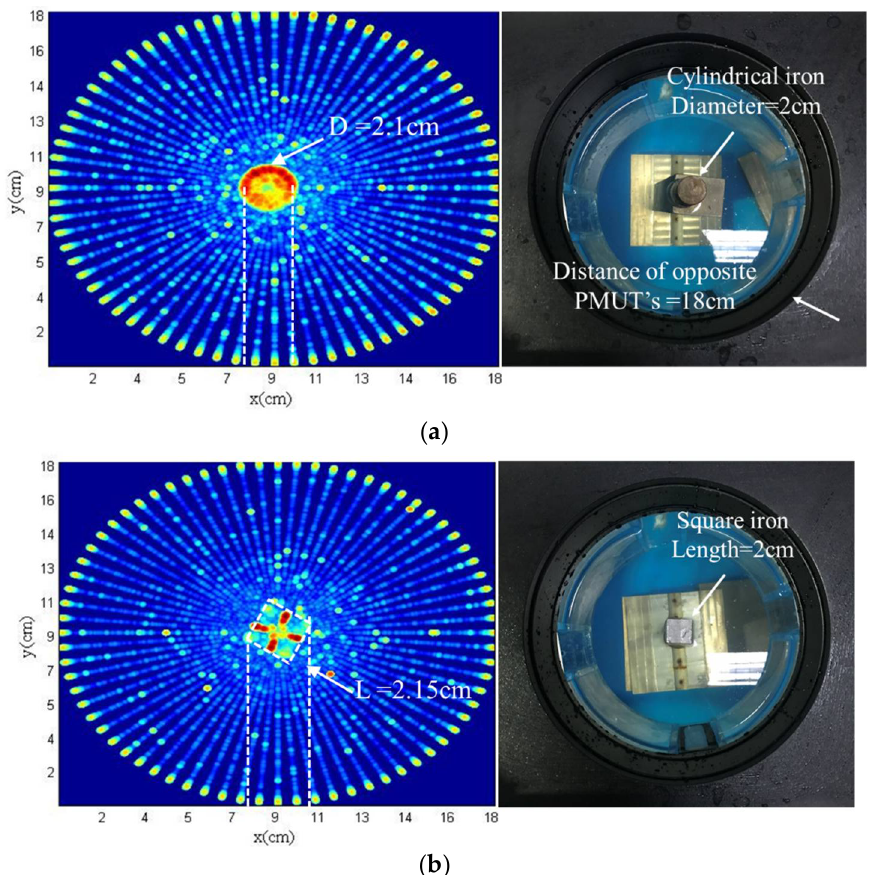
Figure 9. Ultrasonic tomography of iron using the ring system. ( a ) Cylindrical iron imaging and configuration; ( b ) Square iron imaging and configuration.